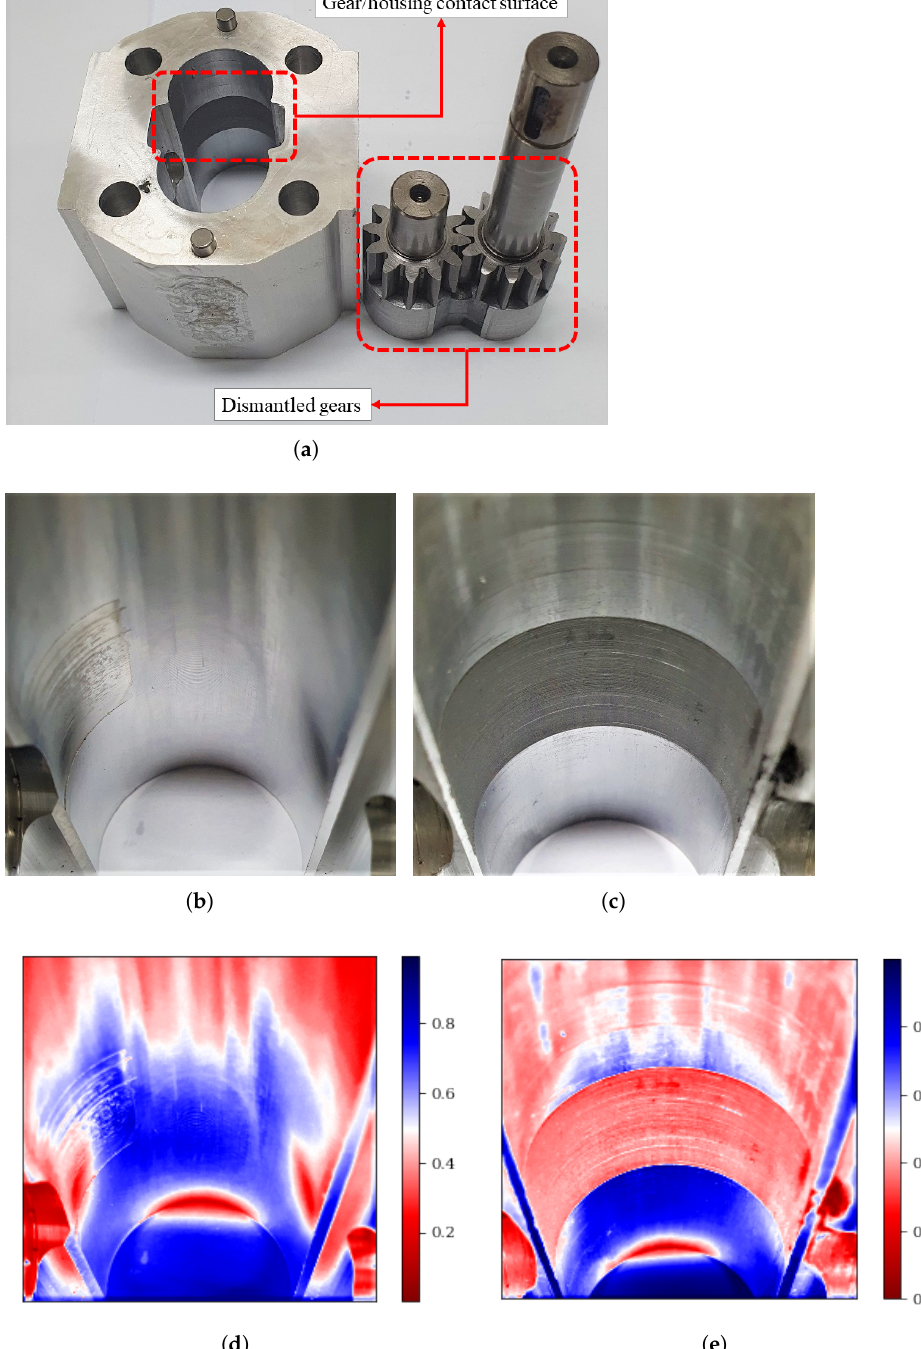
Figure 10. Images of the housing ( a ) showing the contact area between the gears and the housing, ( b ) the contact area with clean working fluid ( c ) the contact area after the abrasion test, ( d ) sur- face profile for contact area with clean working fluid, and ( e ) surface profile for contact area after abrasion